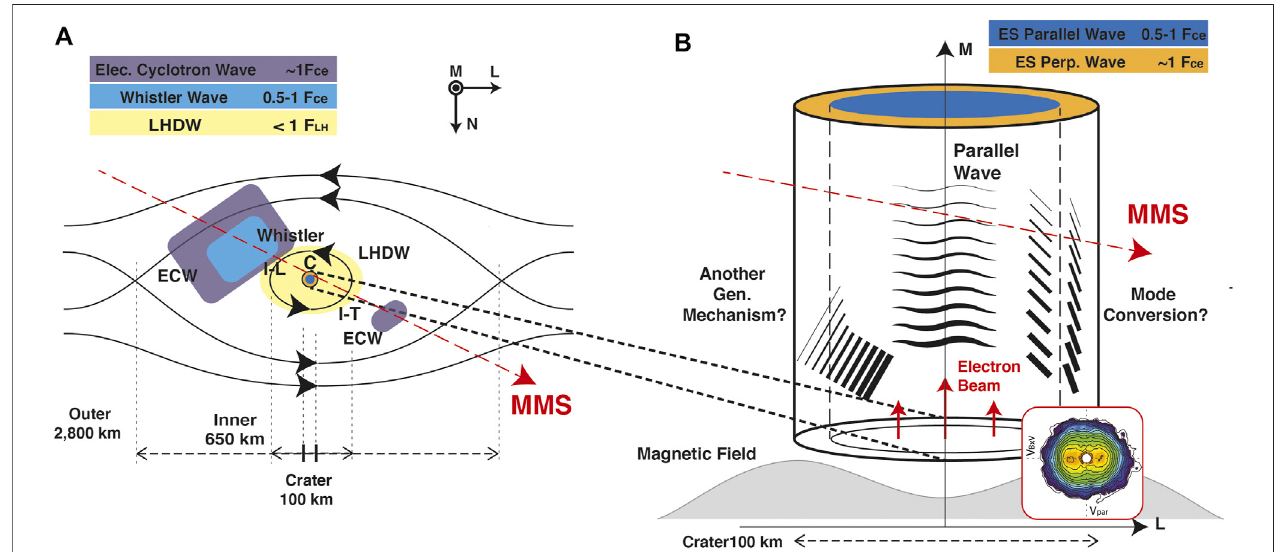
FIGURE4|(A) VariouswavesobservedinMay5.2017event.Wavesobservedin Figure2 areplottedina fl uxropediagram.Red-dashedlineshowsthetrajectory of MMS spacecraft. (B) Waves in the depression of magnetic fi eld at the center of fl ux rope. Two possibilities of perpendicular wave generation are plotted